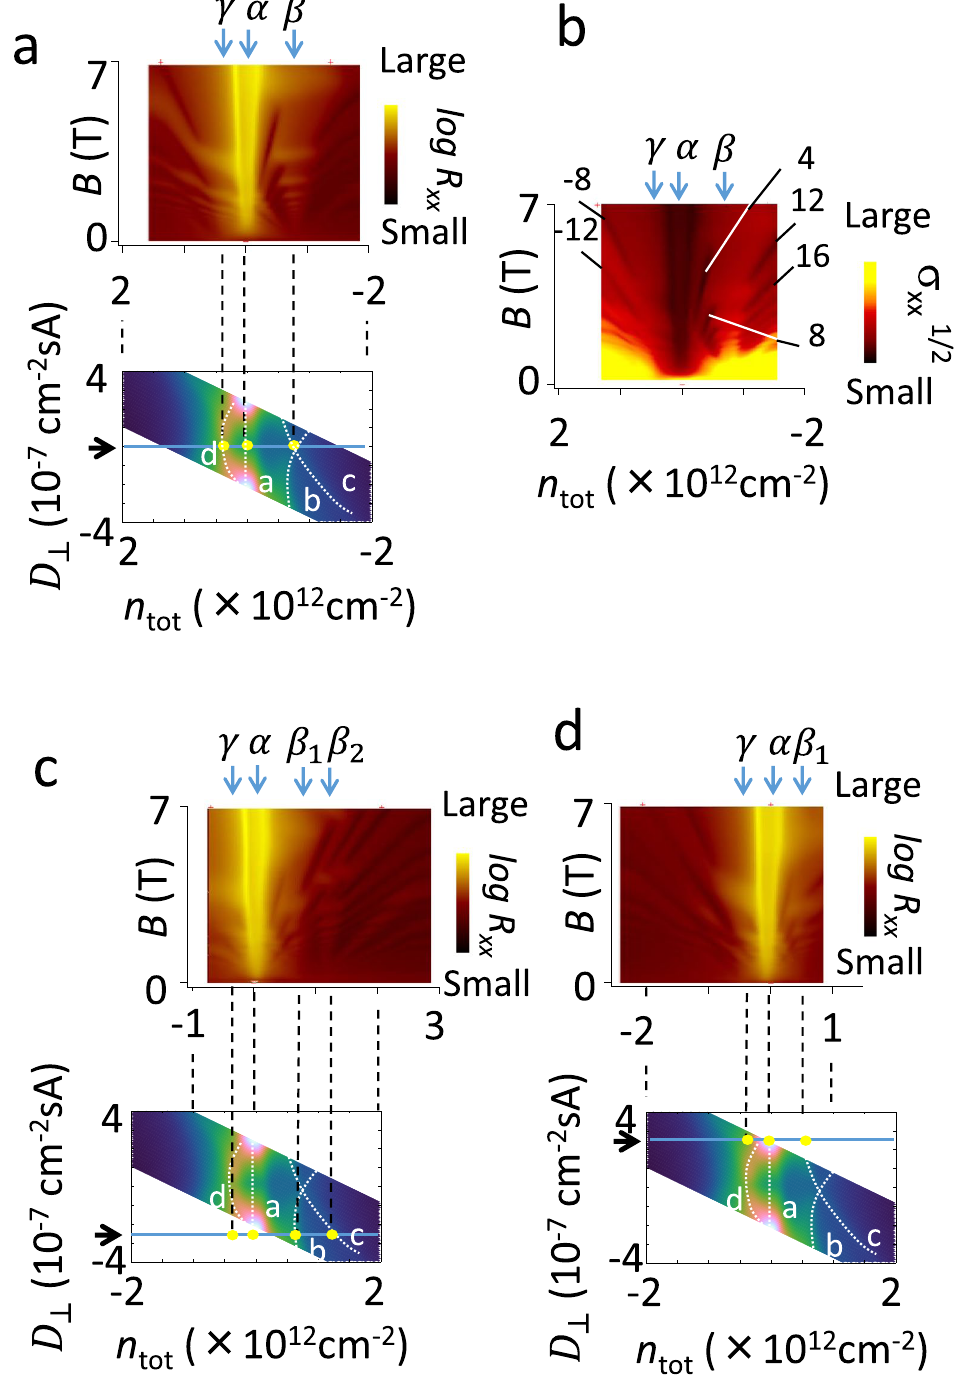
Figure 3. Landau fan diagram of tetralayer graphene. ( a ) (Top) Map of longitudinal resistivity R xx at zero perpendicular electric flux density, D ⊥ = 0. T = 4.2 K. β and γ indicate position of zero-mode Landau levels of light-mass bilayer-like band and heavy-mass bilayer-like band. α indicates position of energy gap which appears at the charge neutrality point. (Bottom) Resistance ridge structure at zero magnetic field (the same as Fig. 2c) Filled yellow circles indicate positions of the zero-mode Landau levels and charge neutrality point. ( b ) Map of = 0. Filling factors for some gaps are shown. ( c ) Similar plot as panel a for D σ xx at D ⊥ β β 1 and 2 indicate split zero-mode Landau levels of light-mass bilayer-like band. T panel c for D ⊥ = + 2.7 × 10 − 7 cm − 2 sA. T = 4.2